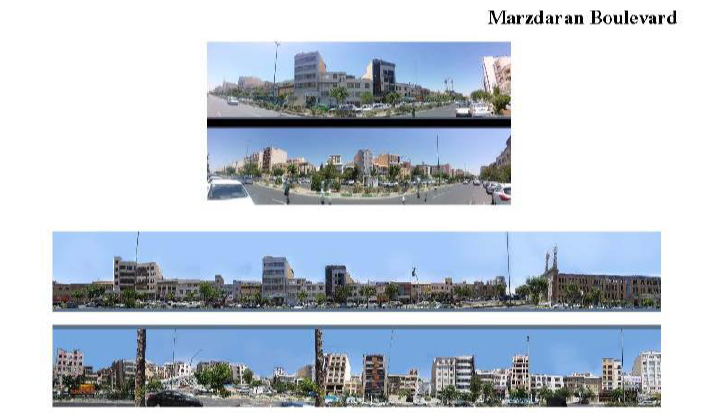
Figure 2. Sample photos of selected streets.